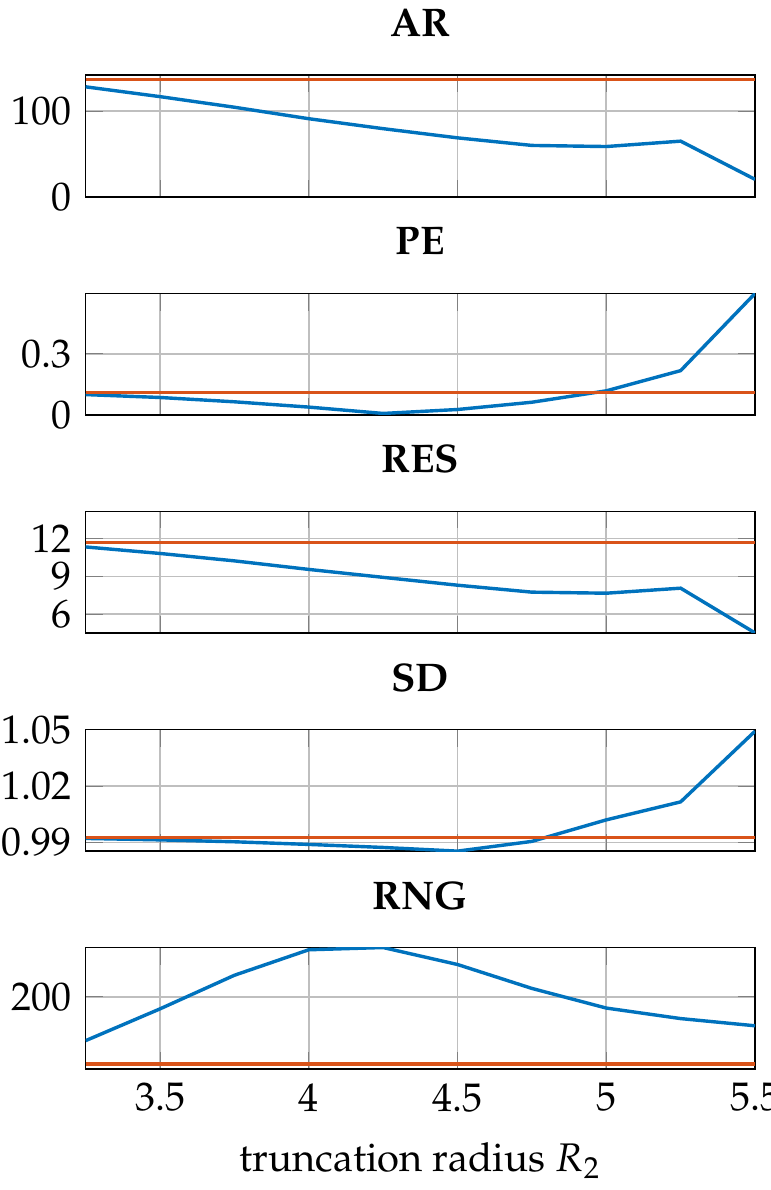
Figure 12. GREIT figures of merit for the combination of EIT and radar data, for R 1 = 3 without noise. The orange line represents the scores of the EIT-only data. R 2 was increased from 3.25 to 5.5 in steps of 0.25.